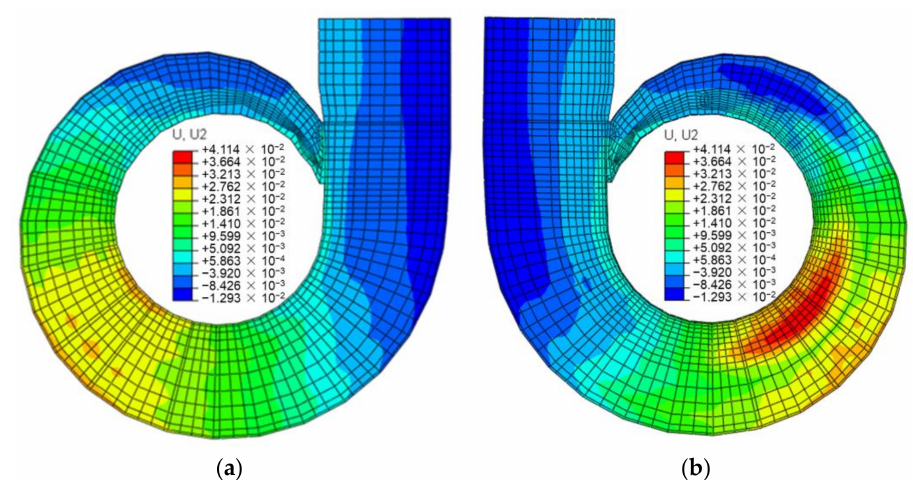
Figure 13. Raising deformation of the upper flange.